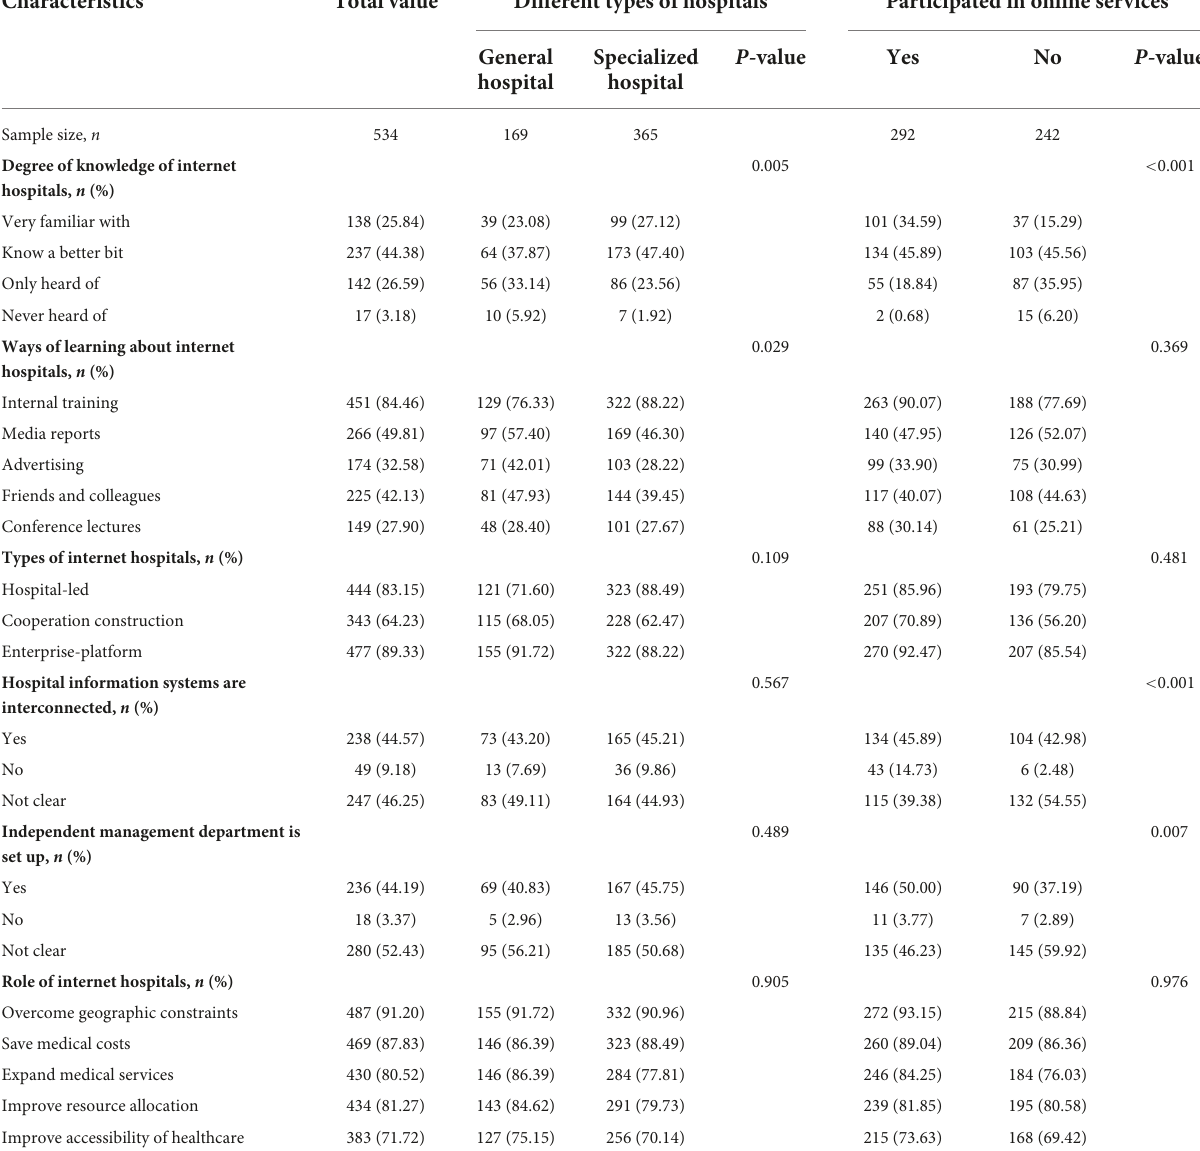
TABLE 2 Awareness of internet hospitals among study participants ( N =